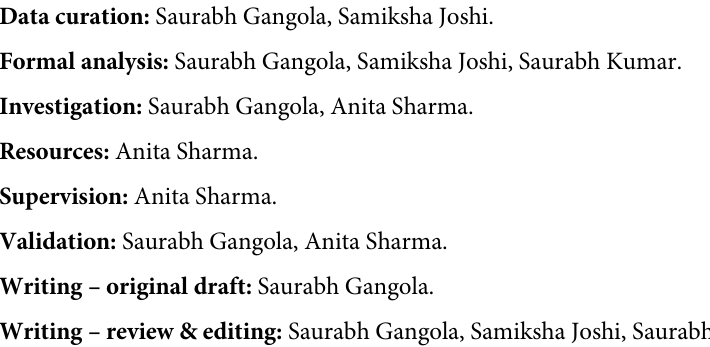
S2 Fig. GC-MS chromatogram of cypermethrin intermediates under the treatment of bac- terial isolate 2D after 15 days. (TIF) S3 Fig. 16S rDNA amplification of bacterial isolate (2D) denoted by red encircled. (TIF) S4 Fig. Phylogenetic analysis of Bacillus cereus 2D by using neighbor joining method. (TIF) S5 Fig. Analysis of expression of extracellular proteins under normal and stress condition (presence of pesticides) in bacterial strain 2D. Bacterial strains designated as 2D in lane number 5 and 2DN in lane number 4 respectively under stress and normal condition. The bac- terial proteins expressed in stress conditions are denoted by highlighted encircled. (TIF) S6 Fig. 2D- electrophoresis for strain 2D in normal condition (2DN). (TIF) S7 Fig. 2D- electrophoresis for strain 2D in pesticide stress condition (2D). (TIF) S1 File. Clarification regarding